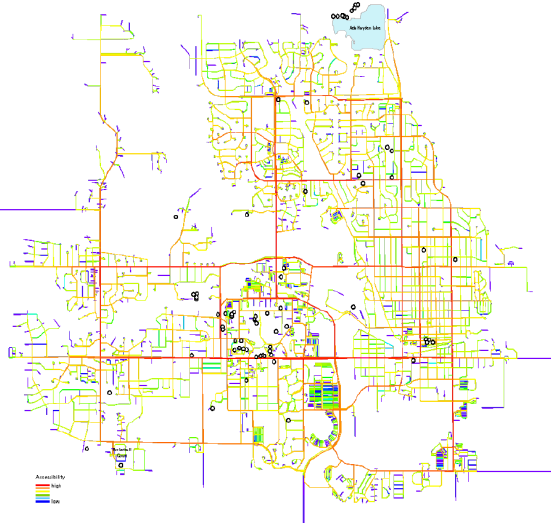
6(b) Zoom-In of the citywide potential through movement: Iowa State University Campus